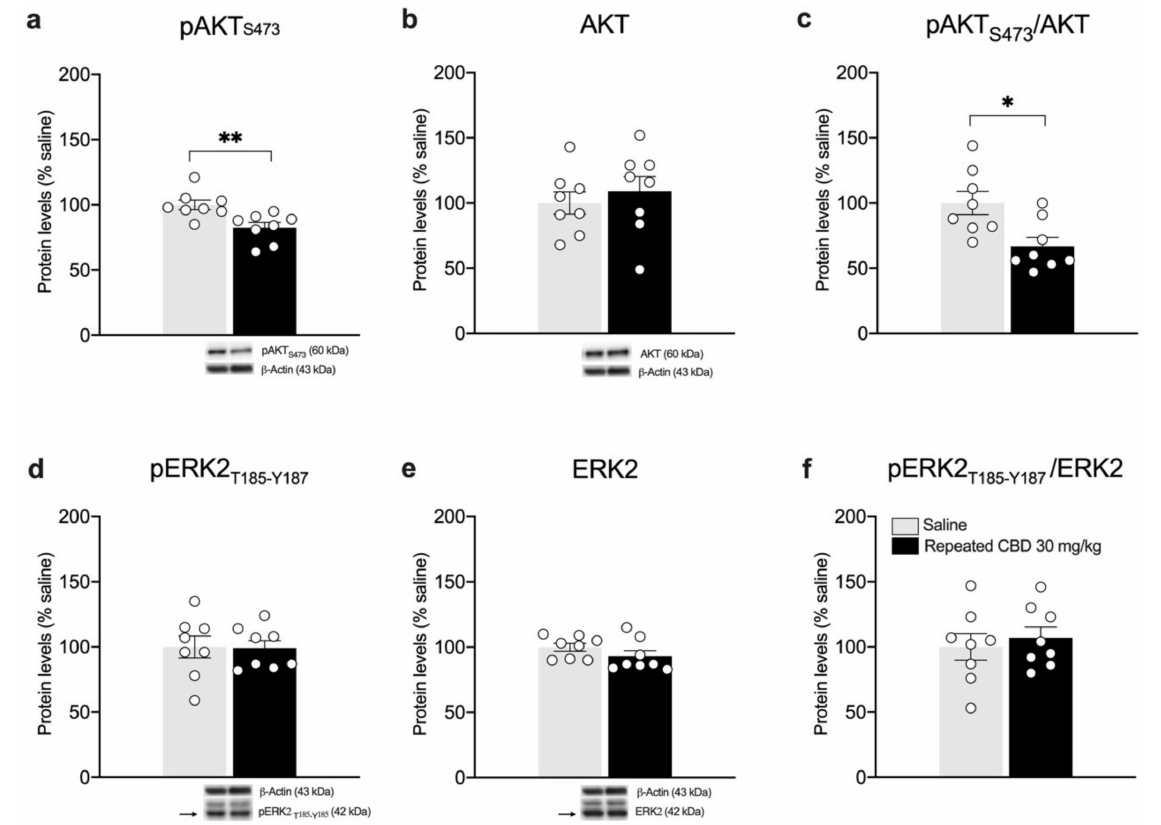
Figure 8. Effects of repeated CBD exposure on BDNF-downstream signaling in the mPFC. Rats were treated with repeated injections of 30 mg/kg for seven days and killed twenty-four hours after the last treatment. Protein levels of phospho(p)-AktS473 ( a ), Akt ( b ), pAkt/Akt ( c ), pERK2T185-Y187 ( d ), ERK2 ( e ), and pERK2/ERK2 ( f ) measured in the homogenate of mPFC are expressed as percentages of saline-treated rats. Below the graphs, representative immunoblots are shown for pAktS473 (60 kDa), Akt (60 kDa), pERK2T185-Y187 (42 kDa), ERK2 (42 kDa), and β -Actin (43 kDa) proteins. Bar graphs represent the mean ± SEM from eight independent determinations for each experimental group. Unpaired Student’s t -test or Wilcoxon − Mann − Whitney test. * p < 0.05, ** p < 0.01 vs. saline-treated rats. Saline n = 8, CBD 30 mg/kg n = 8.